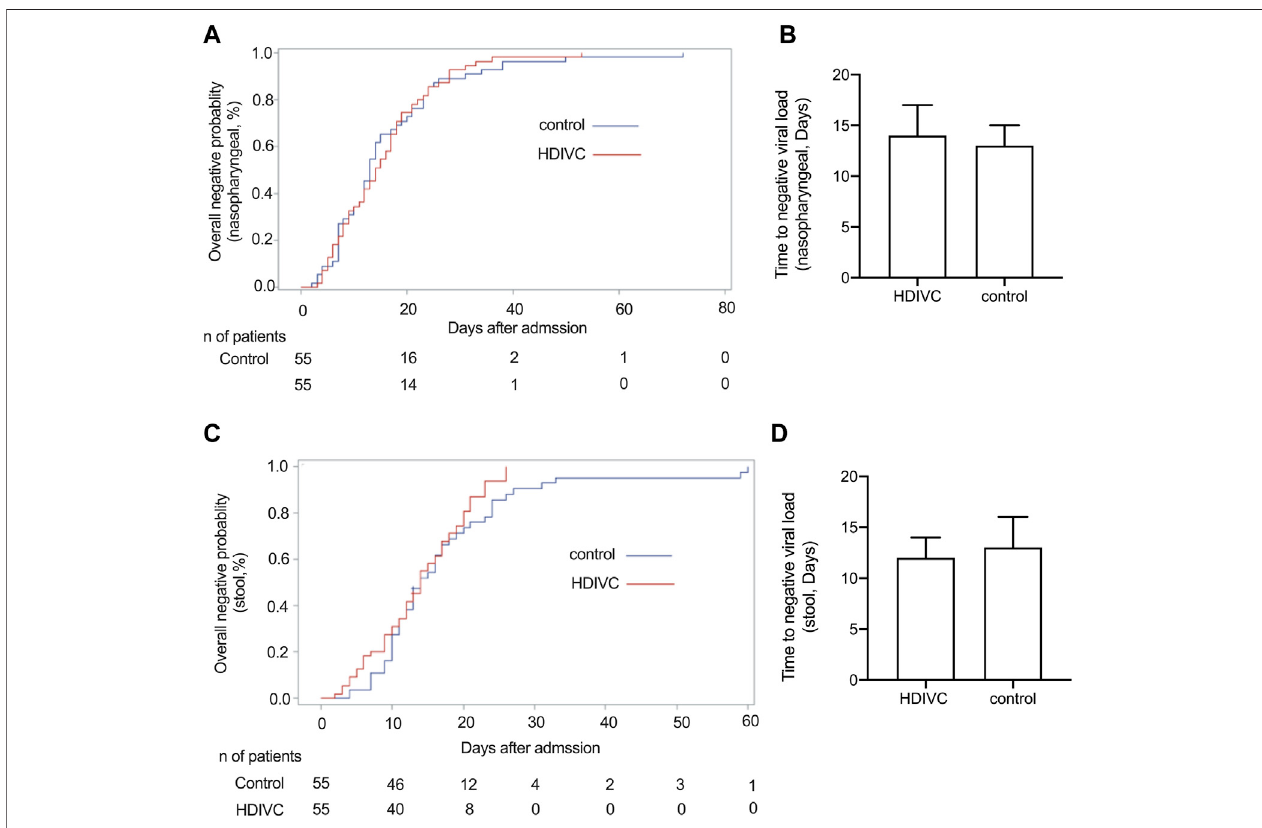
FIGURE 3 | Effect of HDIVC on the time to negative nucleic acid load. The overall negative probability of nasopharyngeal swab (A) and stool (C) at admission between the HDIVC and control groups were compared and no signi fi cant difference was found. The time to negative nucleic acid was compared between HDIVC and control groups for nasopharyngeal swab (B) , median [IQR], days, 14 [8, 21] vs 13 [7, 21], P (cid:1) 0.79) and for stool (D) , median [IQR], days, 12 [7, 17] vs 13 [10, 20], P (cid:1) 0.12). HDIVC, high dose intravenous vitamin C; COVID-19, coronavirus disease 2019. IQR, interquartile